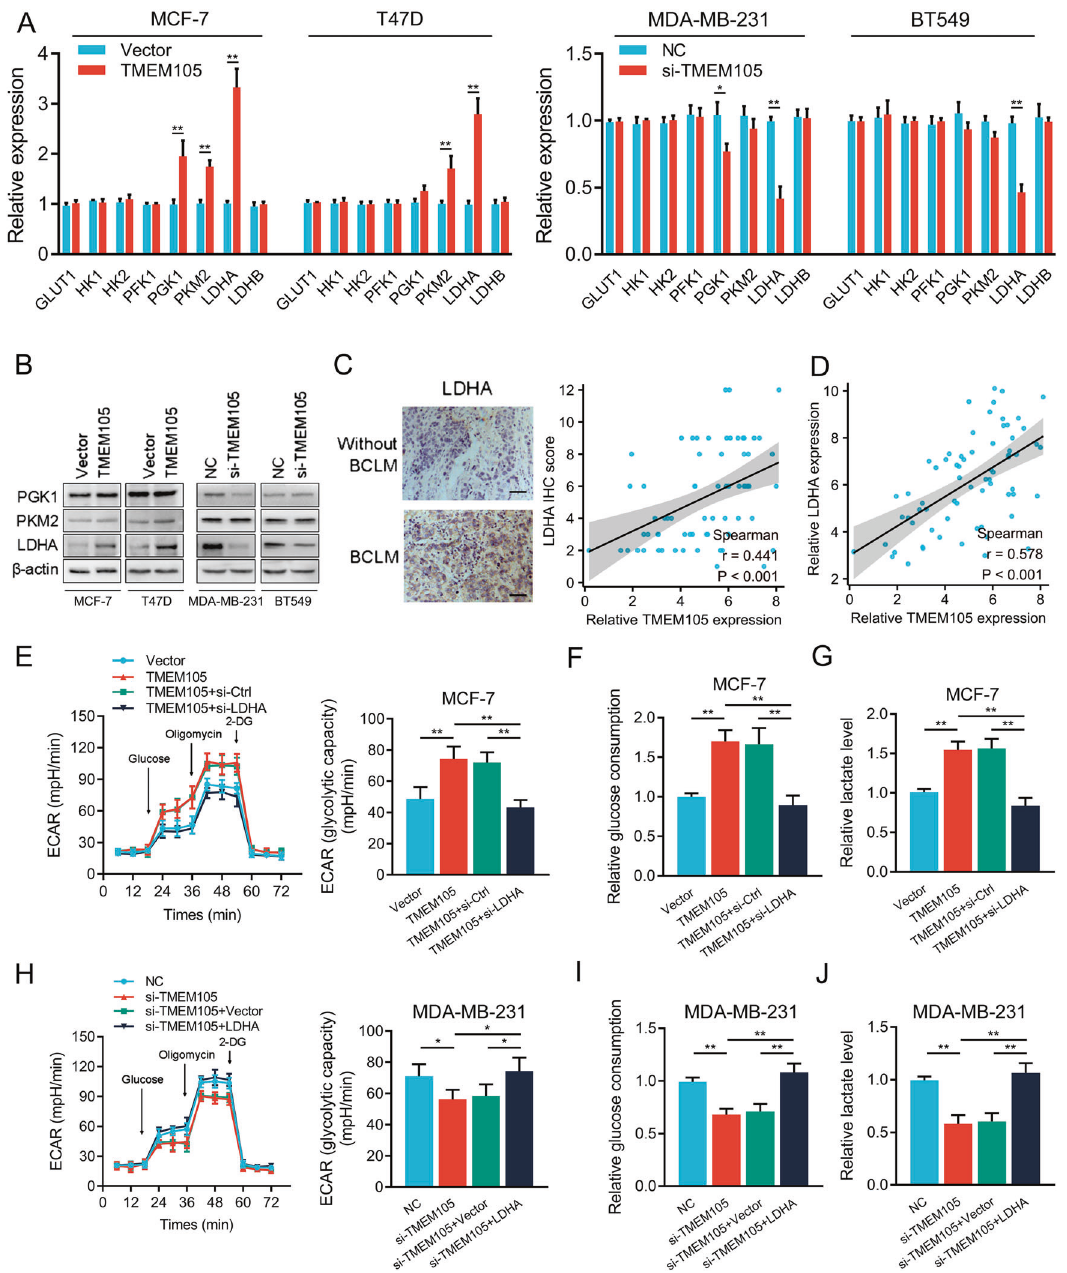
Fig. 3 TMEM105 enhances glycolysis in breast cancer cells by promoting LDHA expression. A Expression of glycolysis-related genes in TMEM105-overexpressing MCF-7 and T47D cells as well as in TMEM105-knockdown MDA-MB-231 and BT549 cells. B Western blot analysis of PGK1, PKM2, and LDHA in TMEM105-overexpressing MCF-7 and T47D cells as well as in TMEM105-knockdown MDA-MB-231 and BT549 cells. C Representative immunohistochemical staining for LDHA expression in breast cancer tissues without or with BCLM. Spearman ’ s correlation between TMEM105 and LDHA expression in breast cancer tissues of the patients in the Hebei dataset ( n = 68). Scale bars, 50 μ m. D The correlation between TMEM105 and LDHA expression determined by qRT-PCR in breast cancer tissues in the Hebei dataset. ECAR level ( E ), glucose consumption ( F ), and lactate production ( G ) were determined in TMEM105-overexpressing MCF-7 cells. ECAR level ( H ), glucose consumption ( I ), and lactate production ( J ) were determined in TMEM105-knockdown MDA-MB-231 cells. * p < 0.05, ** p <